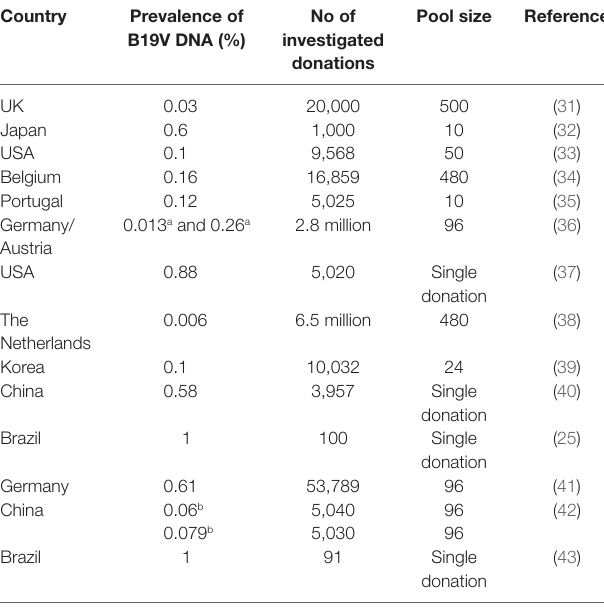
TaBLe 1 | Seroprevalence, measured by anti-parvovirus B19 IgG determination, in blood donors. Country Seroprevalence